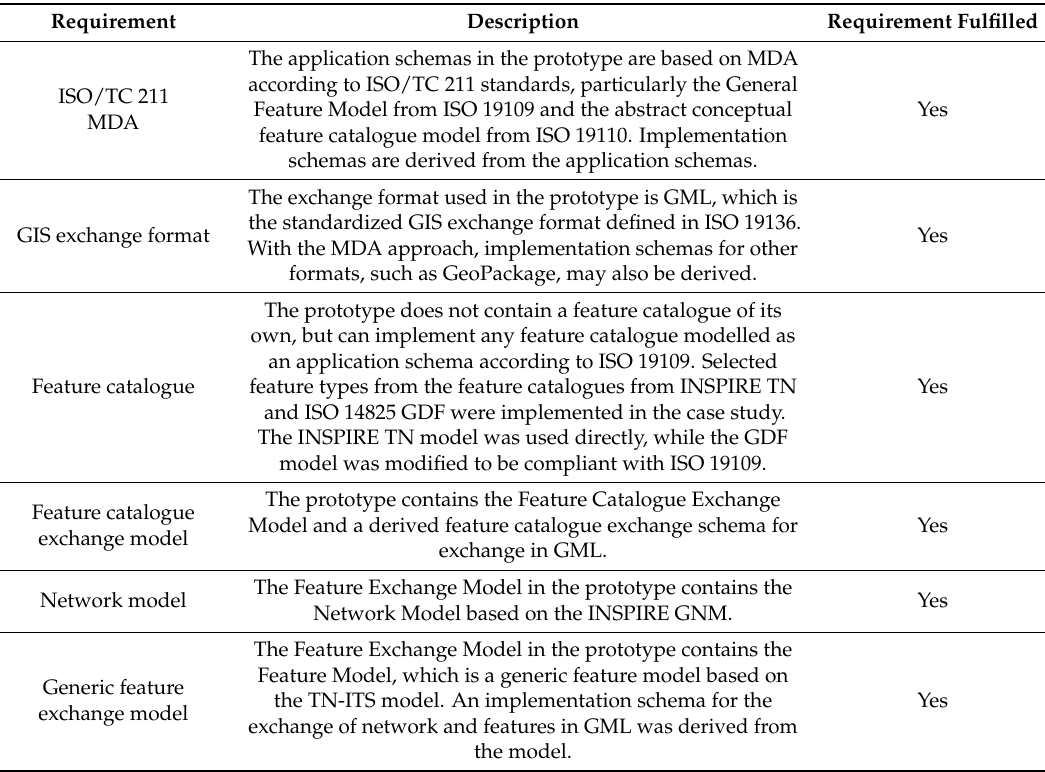
Table 4. Evaluation of the